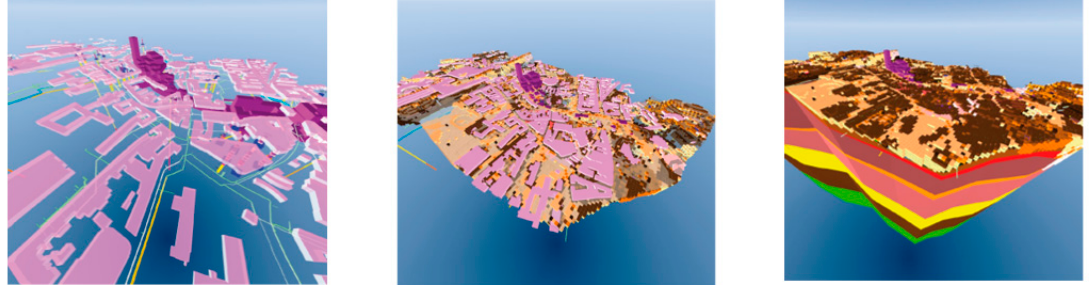
Figure 8. Visualization of Thomas B Thriges District (in dark purple). On the left is anthropogenic data; in the middle the anthropogenic layer; on the right the combined geological and anthropogenic model [25,30].